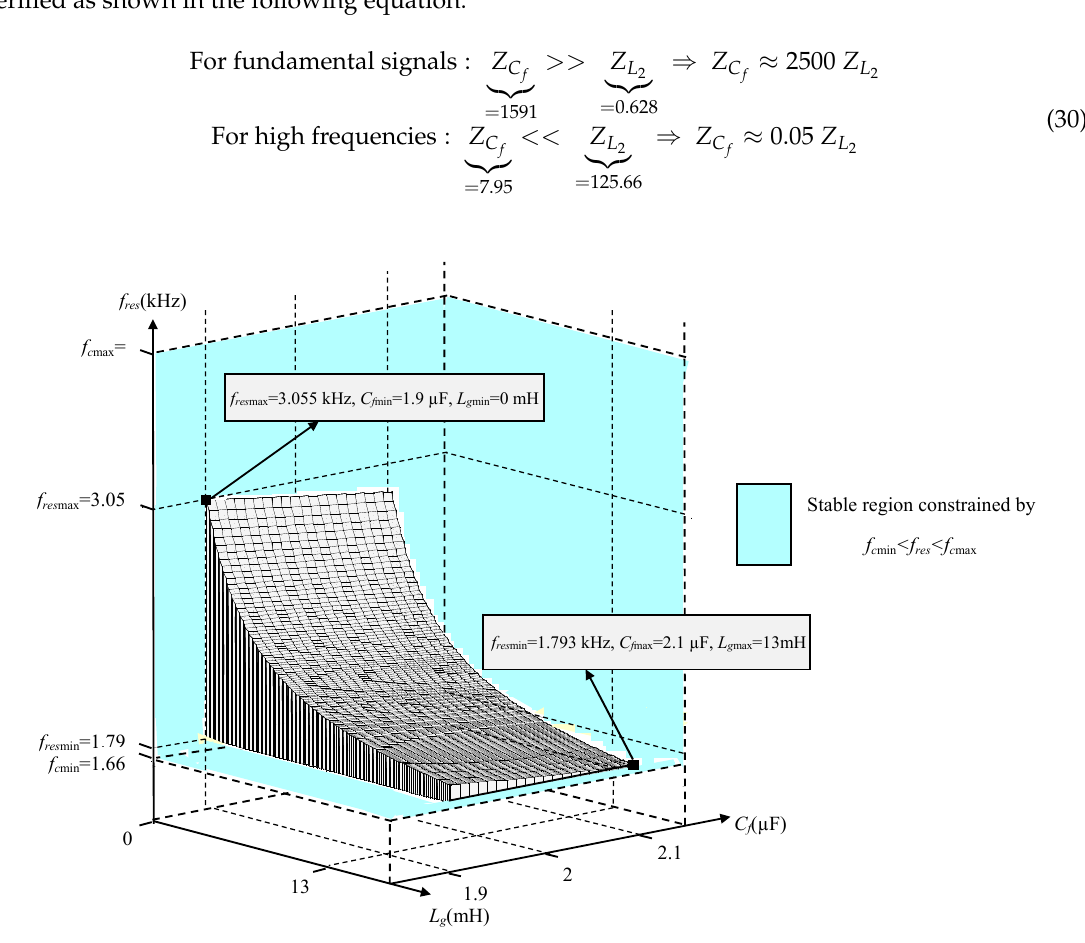
Figure 6. Resonance frequency according to grid inductor and filter capacitor accuracy.